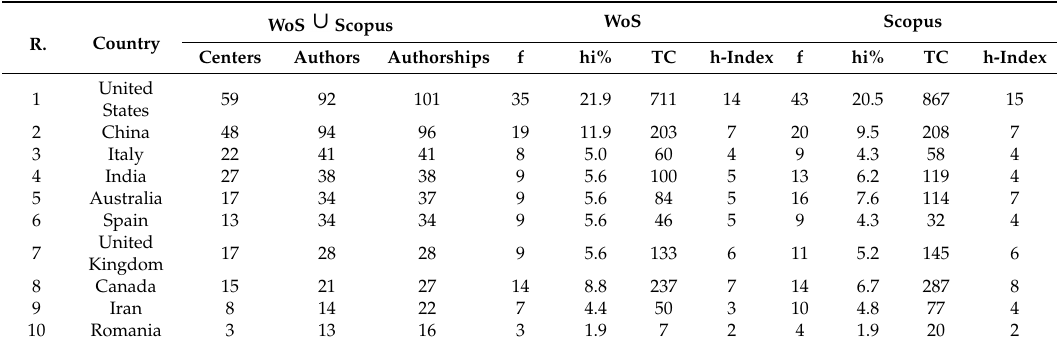
Table 7. Top 10 countries of affiliation of the authors by the number of